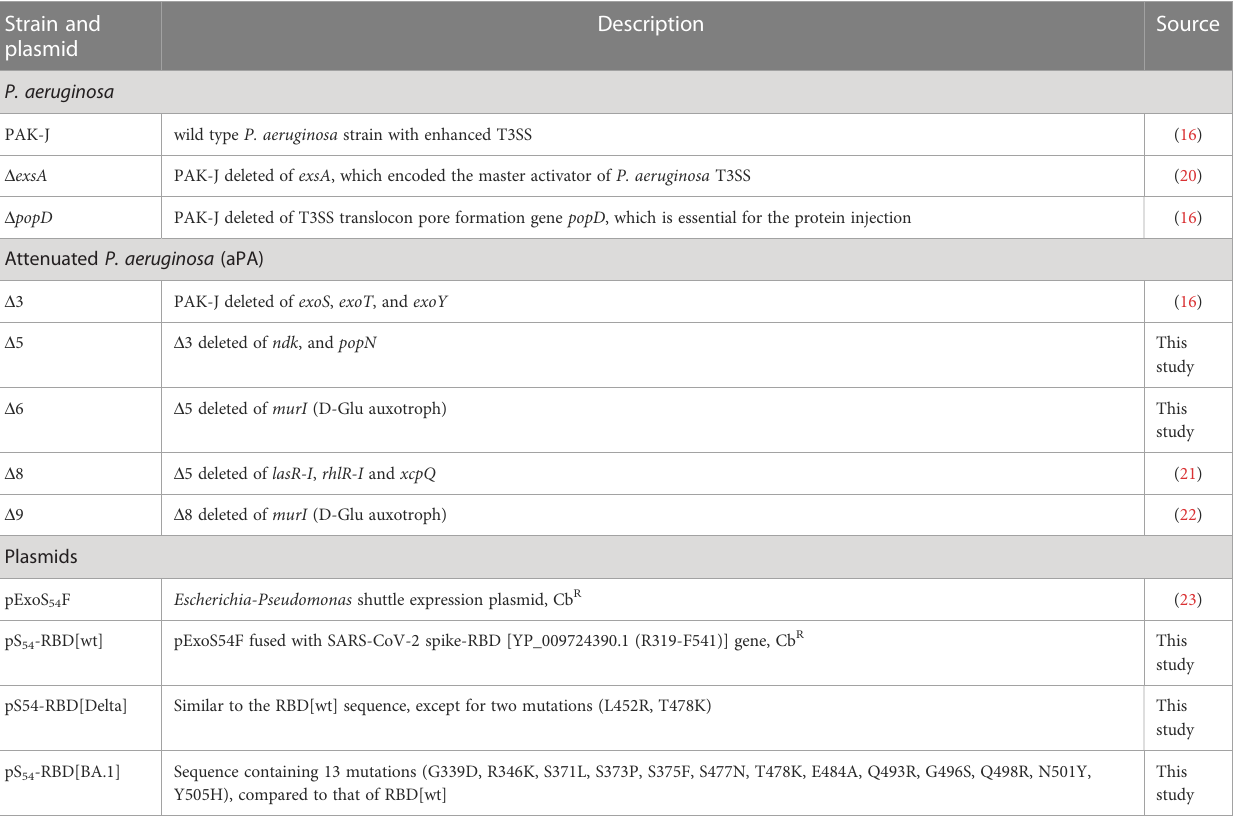
TABLE 1 P. aeruginosa strains and plasmids used in this study. Strain and plasmid